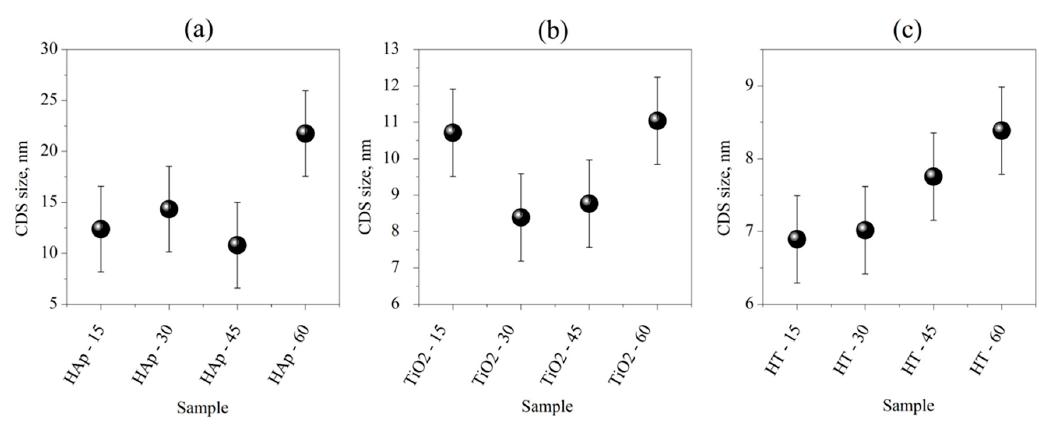
Figure 4. Coherent scattering domain (CSD) sizes ( a ) HAp, ( b ) TiO 2 , and ( c ) HT determined by Scherrer’s equation.